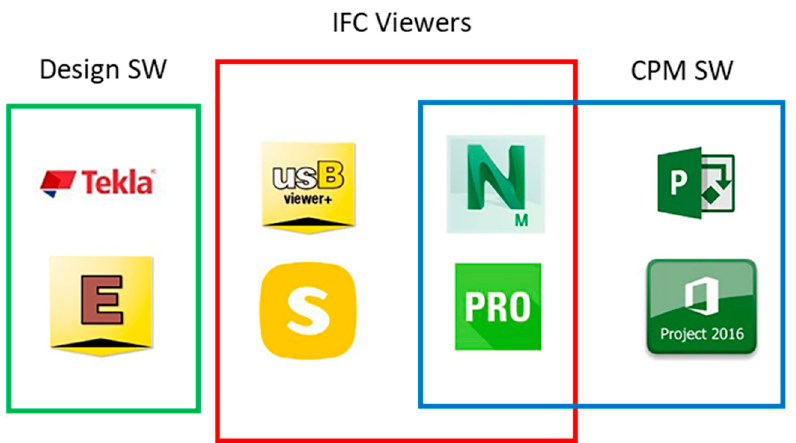
Figure 1. Categorization of software packages selected for cross-checking their interoperability capabilities.